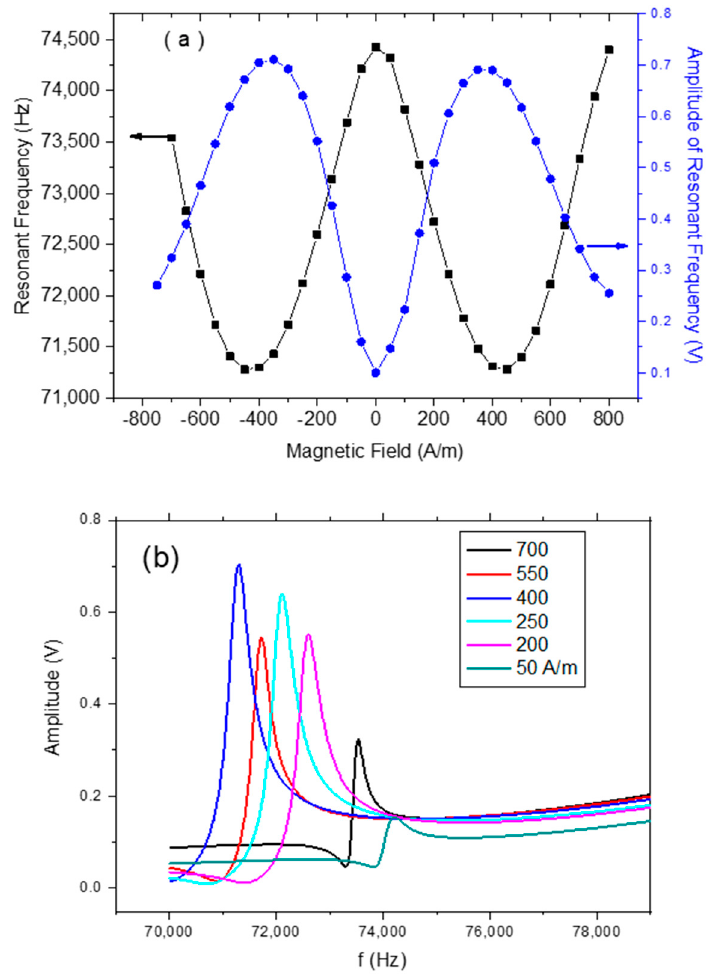
Figure 4. ( a ) Magnetic field dependence of resonant frequency and vibration amplitude of magnetoelastic sensors (MES)-1. ( b ) Frequency spectrum of MES-1 at various magnetic fields.